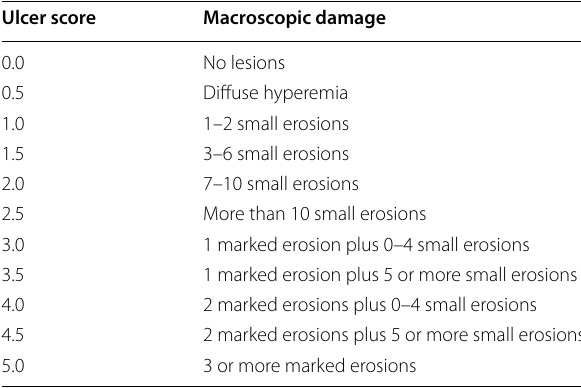
Table 1 Mucosal damage evaluation after pylorus ligation in rats (Small < 2 mm; marked 2 ≥